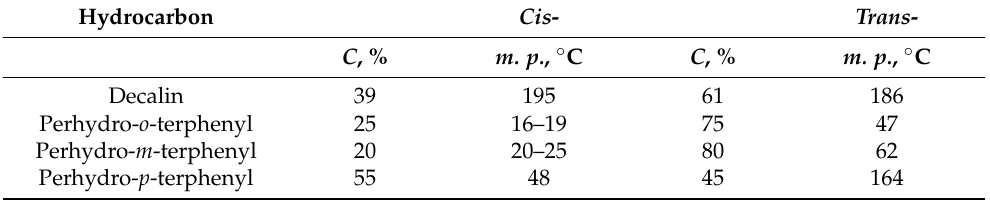
Table 1. Comparison of steric isomers of decalin and perhydroterphenyl ( C is the content in the mixture). Hydrocarbon Cis - Trans - C , % m. p. , ◦ C C , % m. p. , ◦ C Decalin 39 195 61 186 Perhydro- o -terphenyl 25 16–19 75 47 Perhydro- m -terphenyl 20 20–25